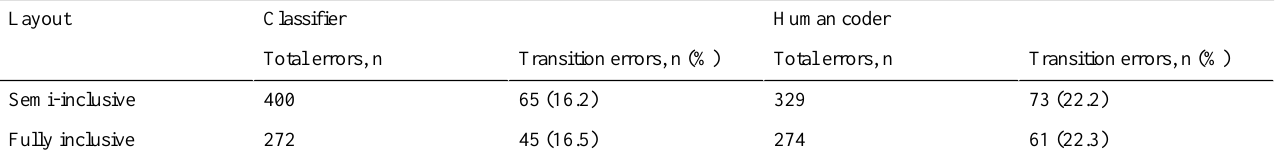
Table 6. Transition-related